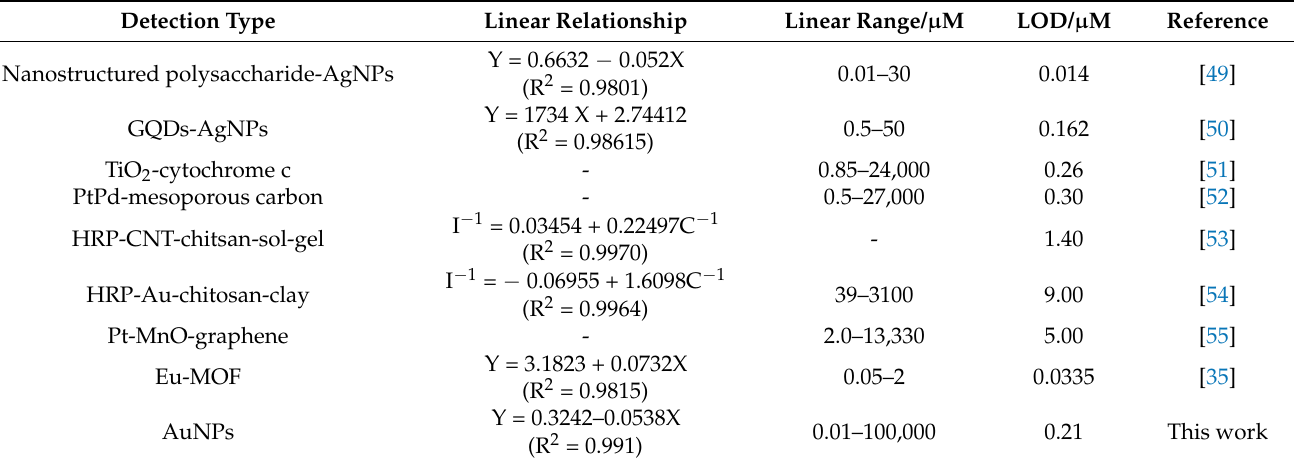
Table 1. Comparison of this work with other methods for H 2 O 2 detection.